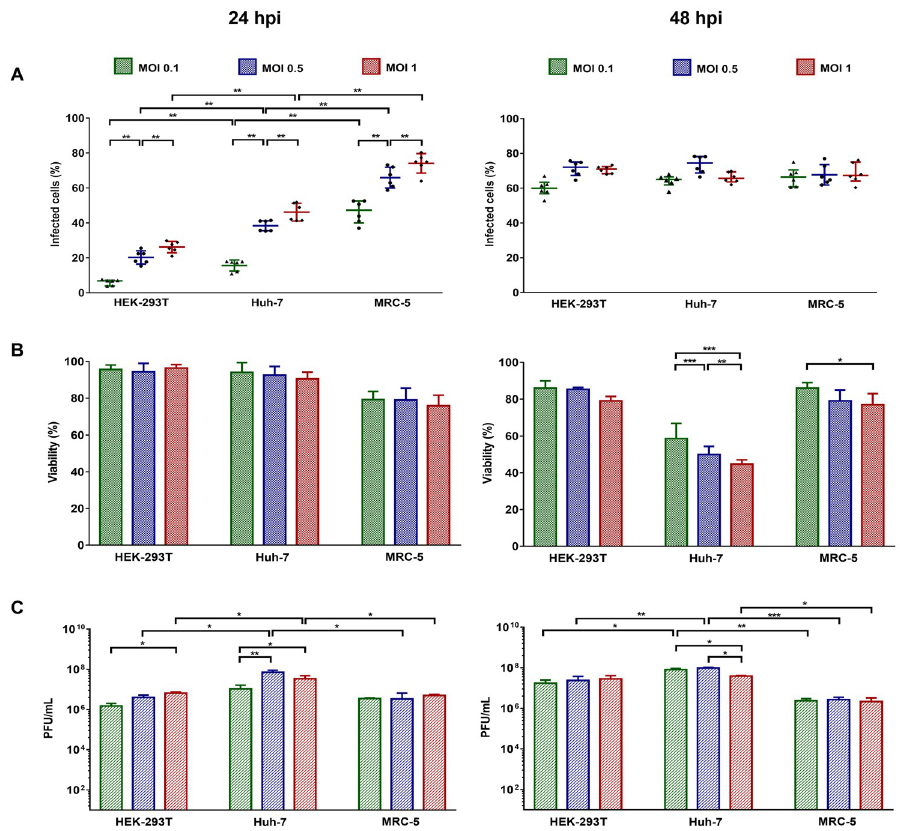
Fig 2. Evaluation of the infective and replicative capacity of the COL7624 CHIKV isolate. Cells were infected at the indicated MOIs. At 24 and 48 hpi, the cells were fixed, permeabilized, stained with anti-E1 CHIKV antibody, and analyzed by flow cytometry (A). Cell viability was analyzed using a resazurin assay (B). Levels of infectious virions in supernatants were measured by plaque assay on Vero cells and are expressed as the number of plaque-forming units (PFU)/mL (C). Significant differences between the groups were evaluated considering the non-parametric Mann– Whitney statistical test ( � P < 0.05; �� P < 0.01; and ��� P < 0.001). Data are representative of three independent experiments (n =